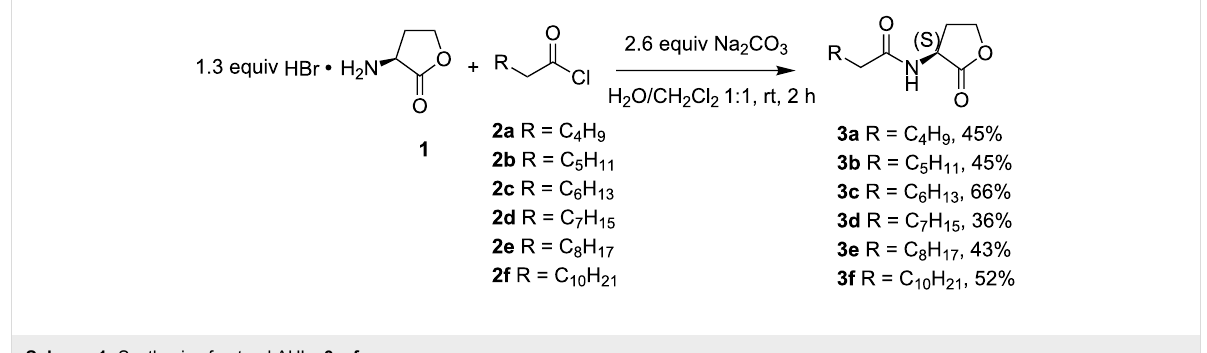
Scheme 1: Synthesis of natural AHLs 3a – f